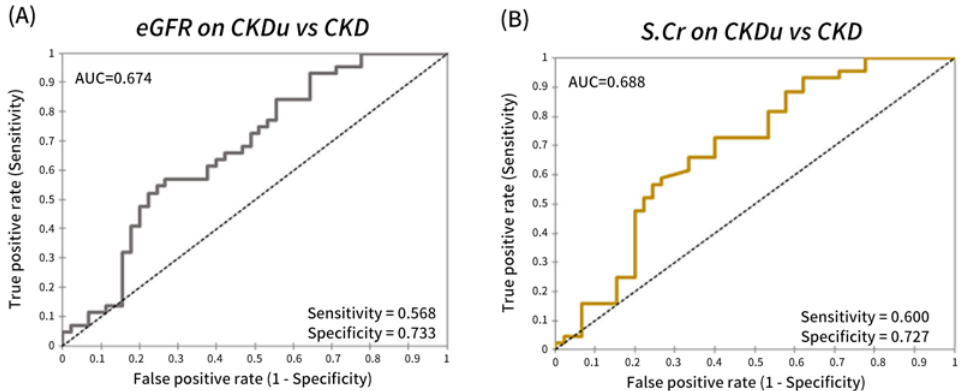
Figure 4. Serum creatinine (S.Cr) and estimated glomerular filtration rate (eGFR) performance as a discriminatory marker between the 2 CKD diseases. ( A ) ROC showing performance of S.Cr as a discriminatory marker for CKD and CKDu. ( B ) ROC showing performance of eGFR as a discriminatory marker between the two chronic kidney